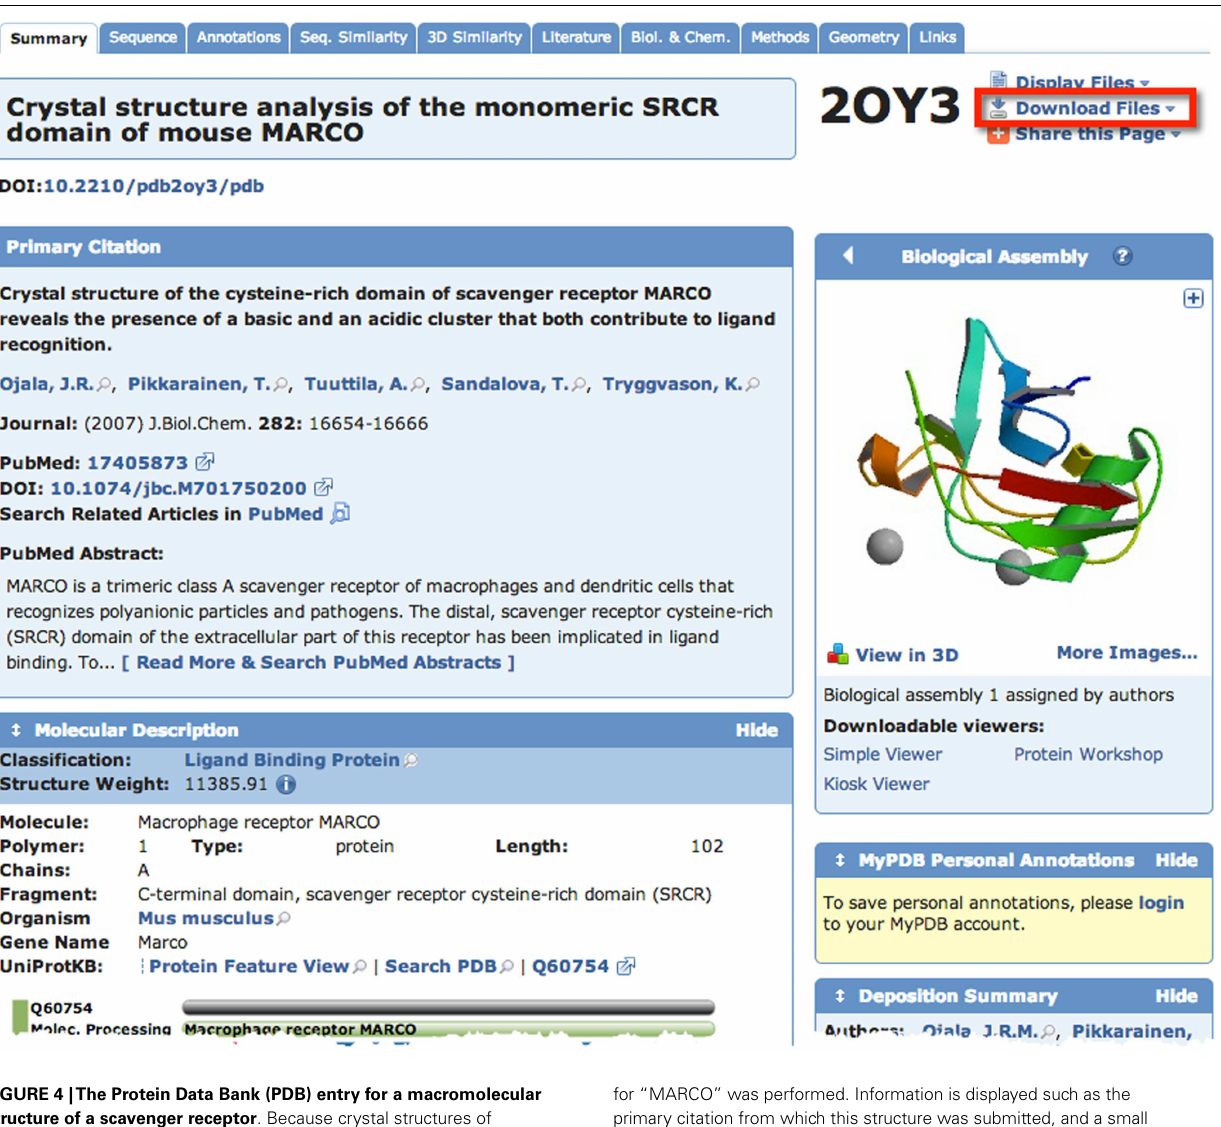
FIGURE 4 |The Protein Data Bank (PDB) entry for a macromolecular structure of a scavenger receptor . Because crystal structures of proteins are more difficult to obtain than their protein sequences, the PDB database is less populated than sequence databases such as NCBI’s Entrez. However, PDB is still an excellent resource. Here, an example of the detailed entry for PDB ID 2OY3 is displayed after a search